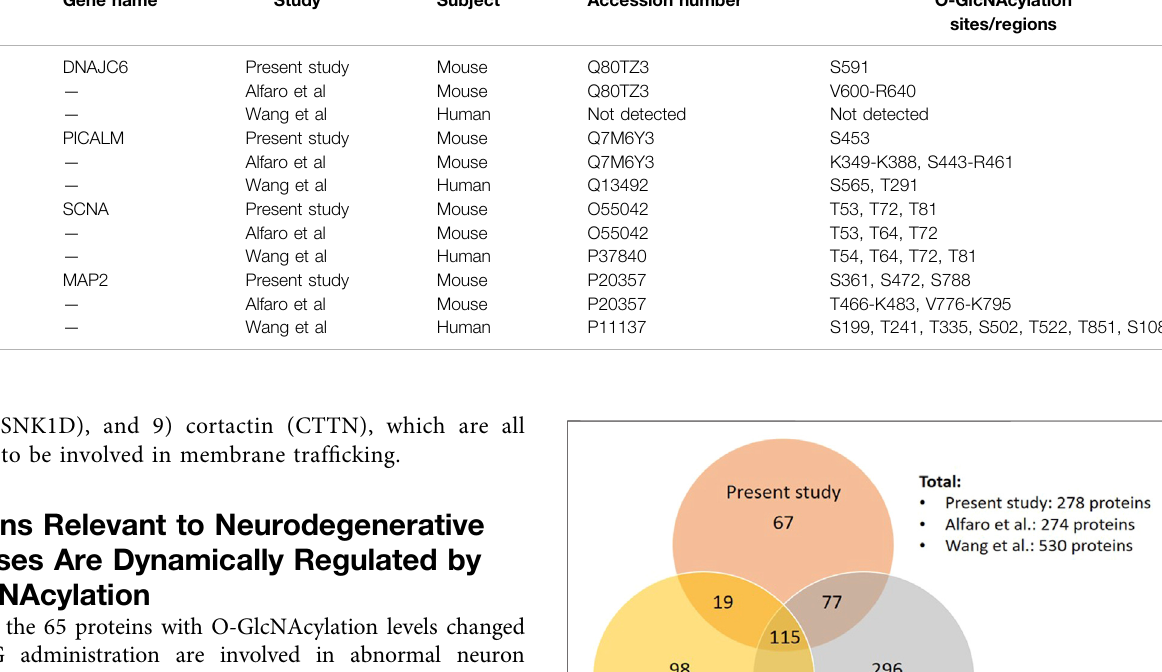
TABLE 1 | O-GlcNAcylation sites of DNAJC6 (AUXI), PICALM, alpha-synuclein (SYUA), and MAP2 identi fi ed in the present study in comparison with the two cortical O-GlcNAcome studies. Protein